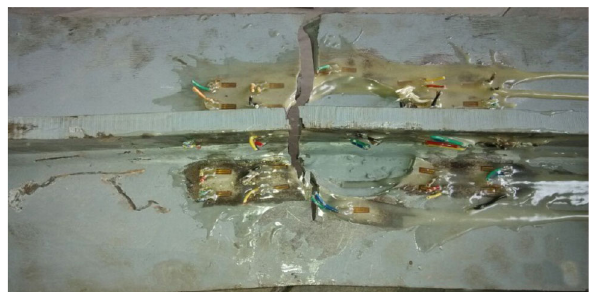
Fig. 3 Fatigue fracture of the specimen